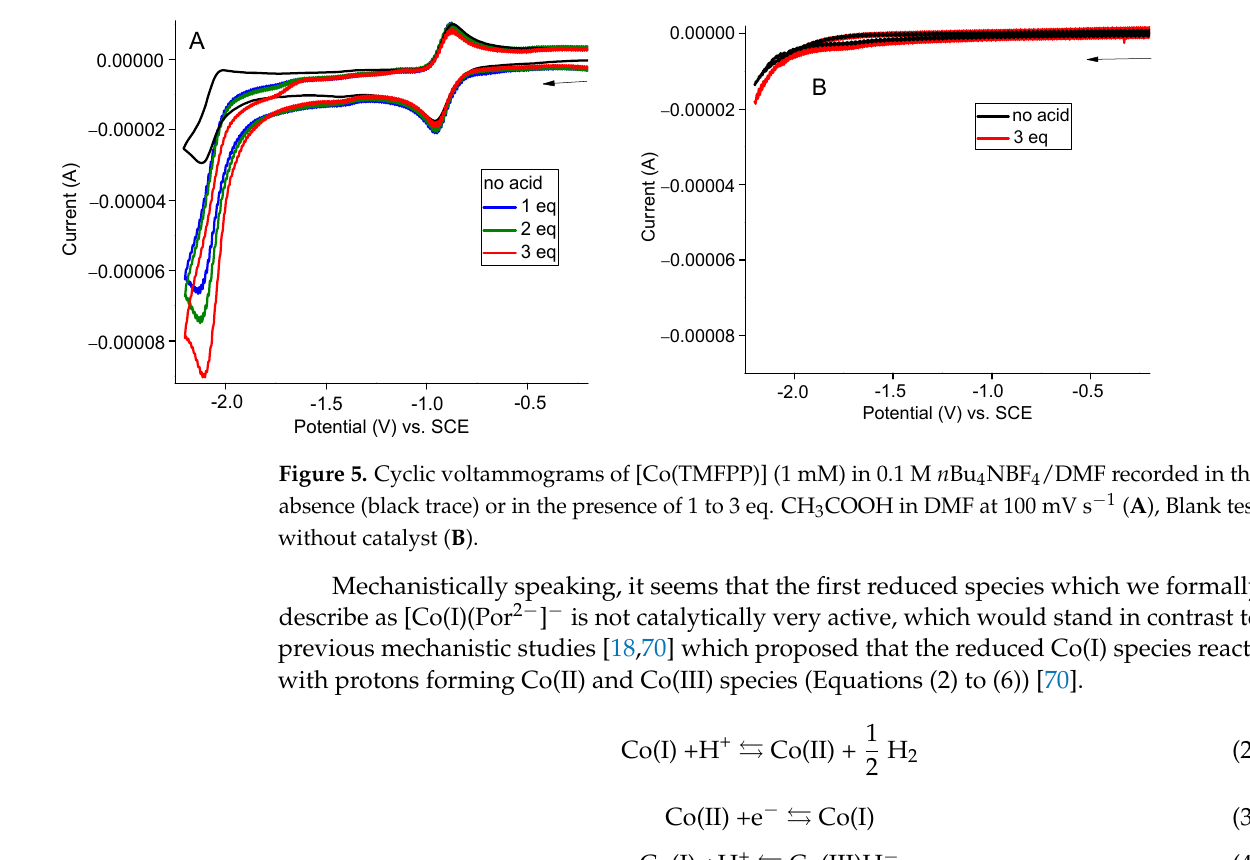
Figure 4. Cyclic voltammograms of [Co(TMFPP)] in 0.1 M n Bu 4 NBF 4 /DMF recorded at different scan rates ( A ). Peak currents vs. square roots of the scan rate for the two reduction processes ( B ).